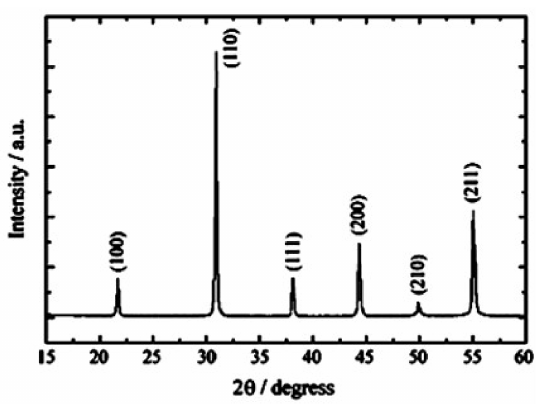
Figure 1. The X-ray diffraction pattern of